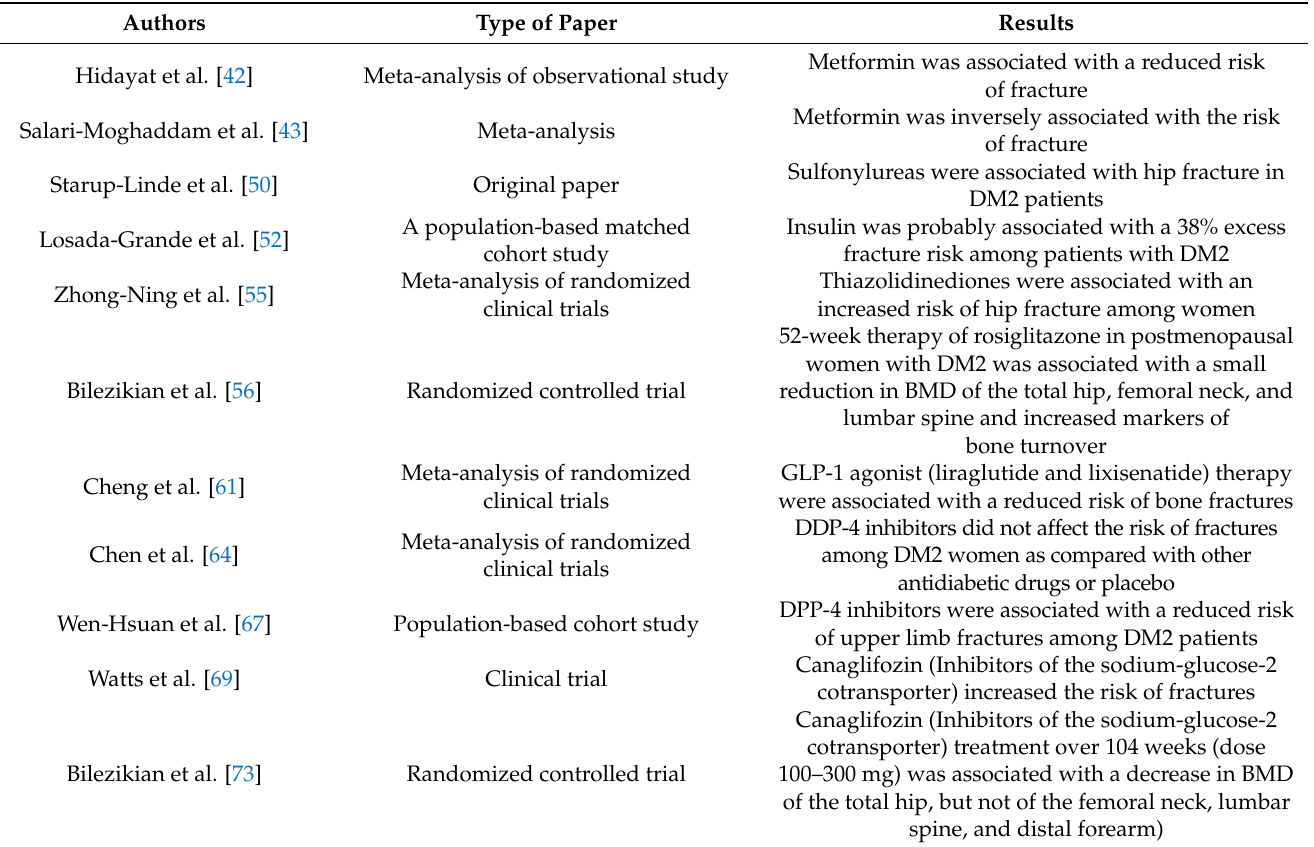
Table 1. Effects of antihyperglycemic drugs on the risk of